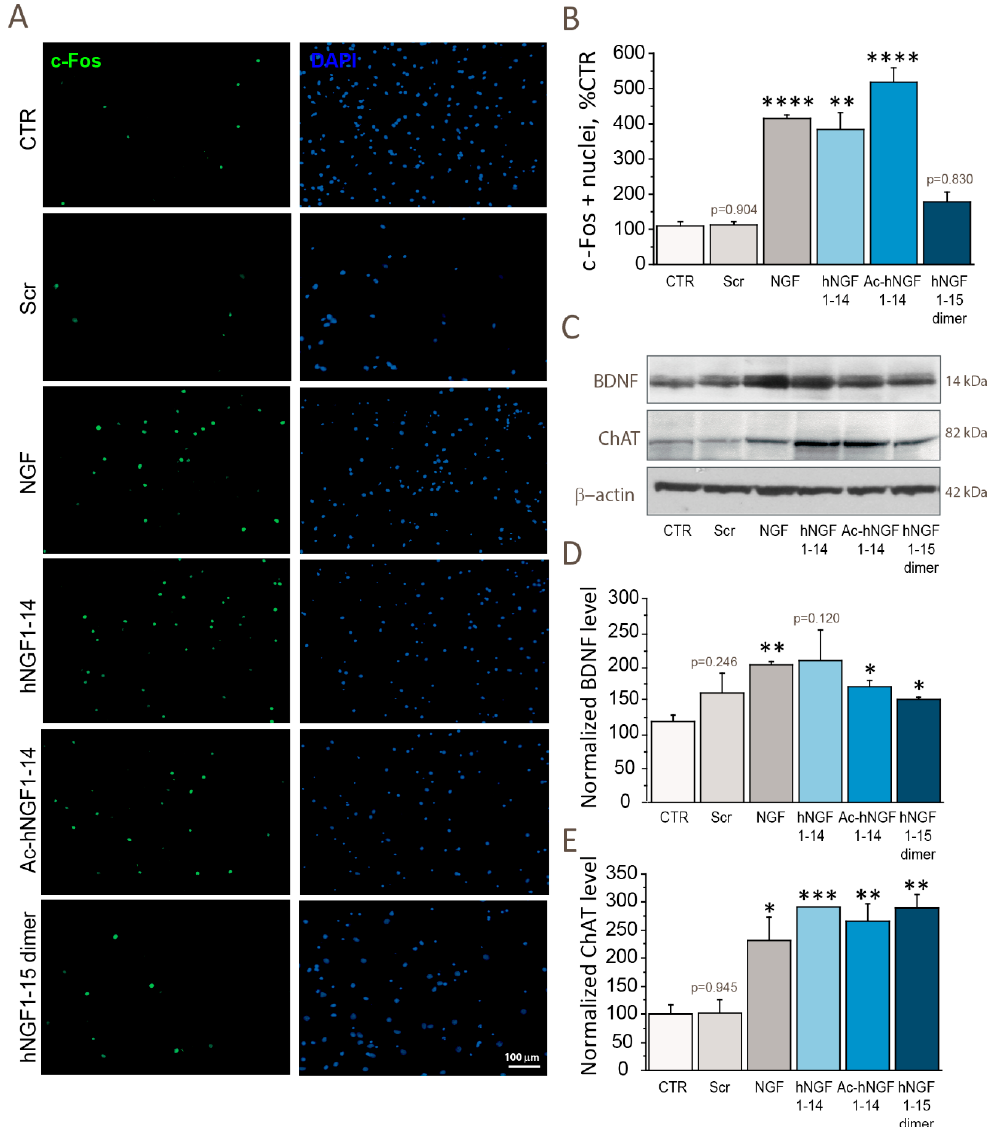
Figure 3. hNGF1–14 peptides mimic NGF by inducing neuronal activity, BDNF and ChAT levels. ( A , B ) Quantitative analysis of the ratio of c-Fos expressing nuclei in cholinergic neurons incubated for 60 (cid:48) with 10 µ M scrambled hNGF1–14 (Scr), 10 µ M hNGF1–14, 10 µ M Ac-hNGF1–14, 10 µ M hNGF1–15 dimer and 100 ng / mL (3.84 nM) NGF. Neurons were immunolabelled for c-Fos and nuclei were counterstained with 4 (cid:48) ,6-diamidino-2-phenylindole (DAPI). The number of c-Fos positive nuclei was calculated as ration over the total number of nuclei per field, and reported as percentage of CTR. ( C , E ) Representative western blotting ( C ) against BDNF and ChAT in cholinergic neurons incubated for 60 (cid:48) with 10 µ M scrambled hNGF1–14 (Scr), 10 µ M hNGF1–14, 10 µ M Ac-hNGF1–14, 10 µ M hNGF1–15 dimer and 100 ng / mL (3.84 nM) NGF. ( D , E ) Densitometric analysis of BDNF ( D ) and ChAT ( E ) level in cholinergic neurons treated for 60 (cid:48) with 10 µ M scrambled hNGF1–14 (Scr), 10 µ M hNGF1–14, 10 µ M Ac-hNGF1–14, 10 µ M hNGF1–15 dimer and 100 ng / mL (3.84 nM) NGF. The c-Fos ( n = 4), BDNF ( n = 3) and ChAT ( n = 3) data were expressed as percentage of CTR and reported as mean ± SEM. The β -actin was used as loading control. * p < 0.05; ** p < 0.01; *** p < 0.001; **** p < 0.0001. Full-length blots are presented in the Supplementary Material. Scale bar = 100 µ